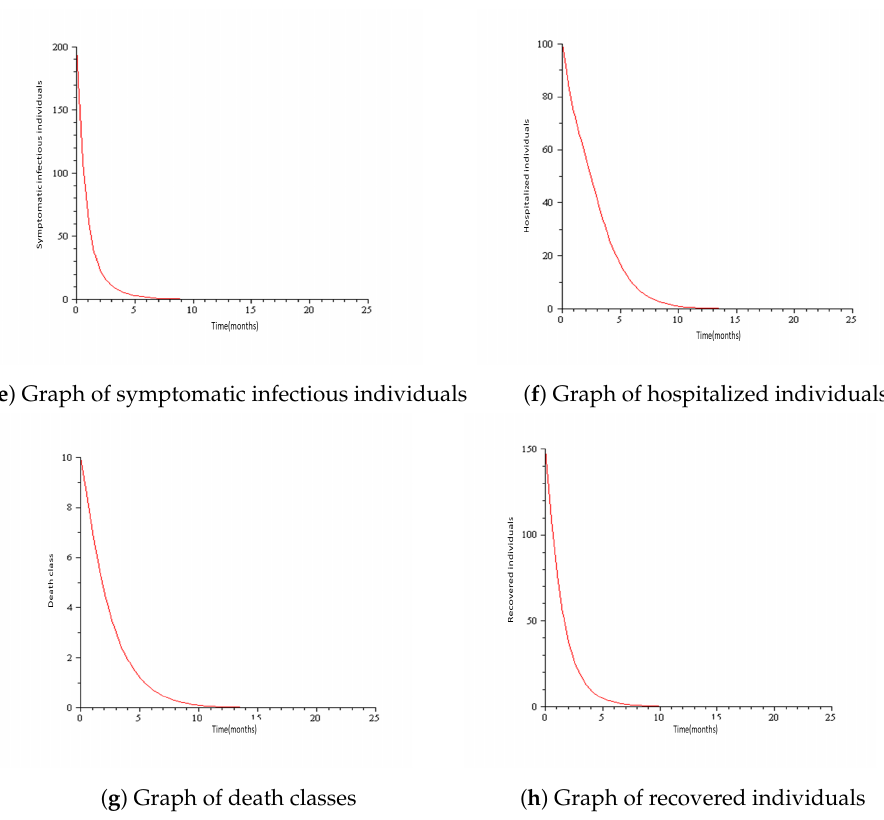
Figure 3. Simulation results showing the global stability of the disease-free equilibrium.